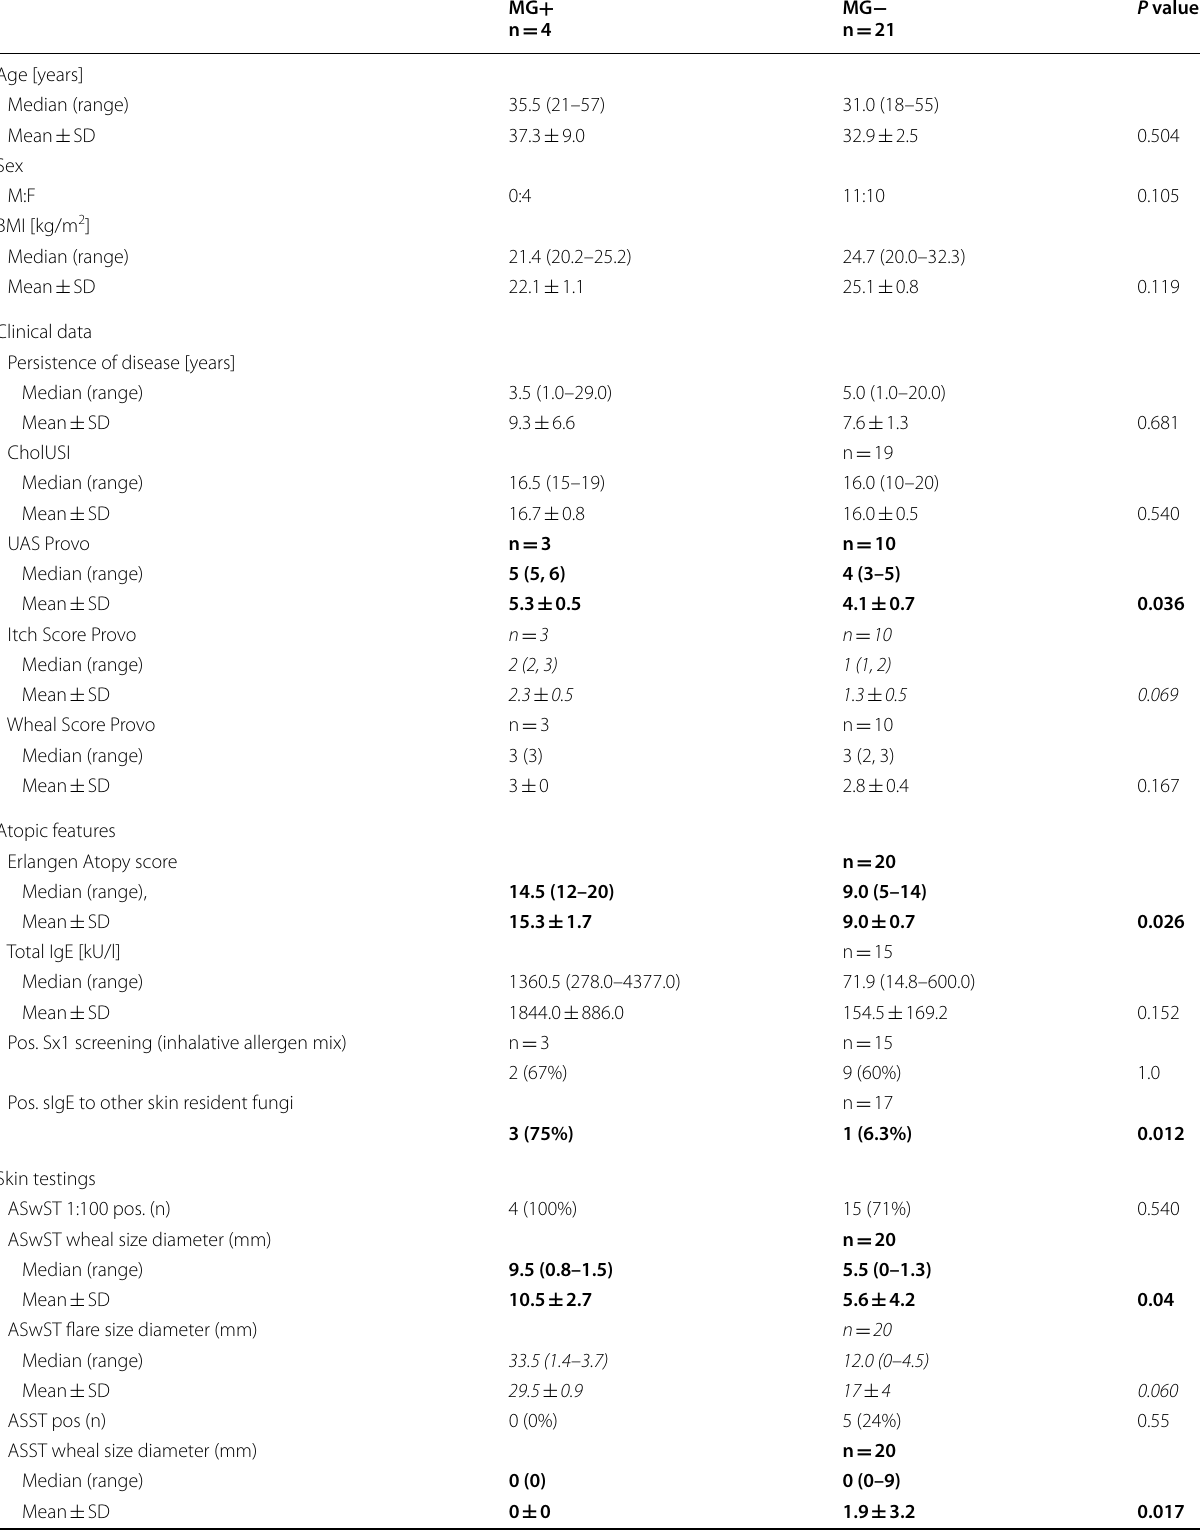
Table 2 Clinical characteristics of CholU patients with elevated specific IgE levels against supMGL-1304 (MG patients with normal low supMGL-1304 (MG